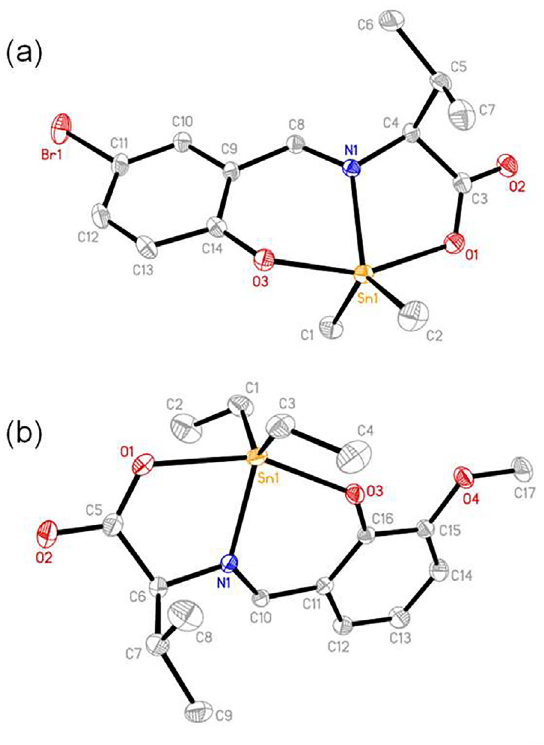
Figure 2: The molecular structures of 2 (a) and 3 (b). Ellipsoids are drawn at the 30% probability level. Hydrogen atoms are omitted for clarity.